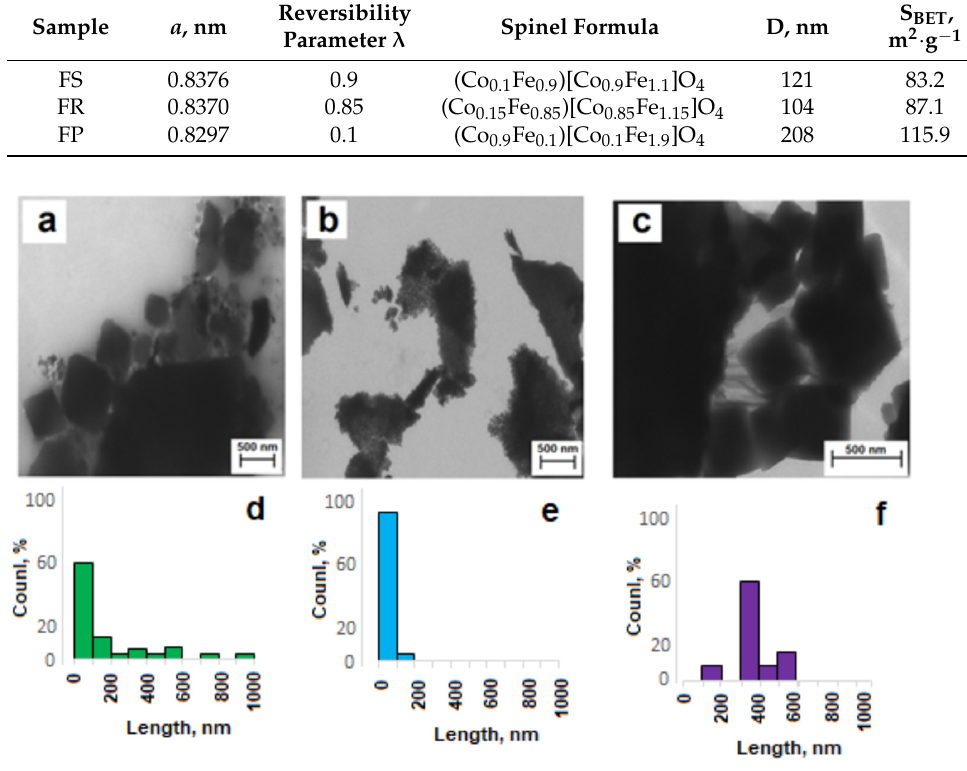
Figure 3. TEM images of synthesized composite materials: ( a , d ) is FS, ( b , e ) is FR, and ( c , f ) is FP.